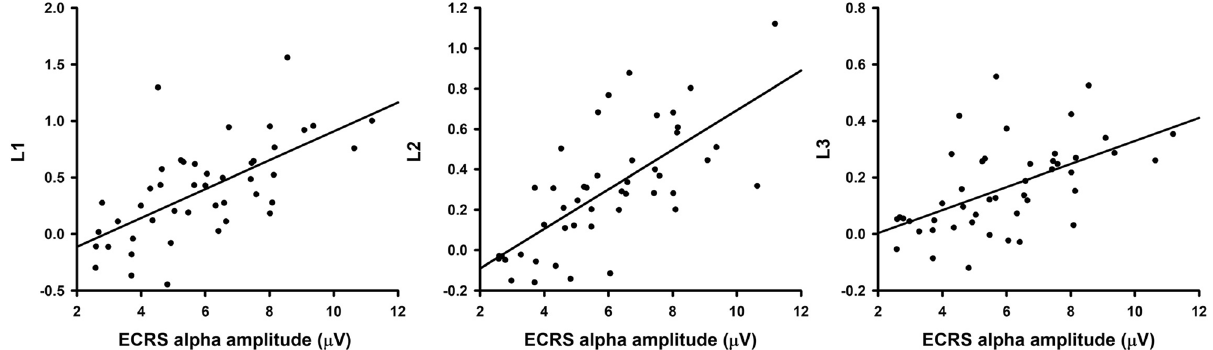
Figure 2. Correlation of the eyes-closed resting-state (ECRS) alpha amplitude with 3 learning indices (L1, L2, and L3 from left to right). Each dot corresponds to one subject.